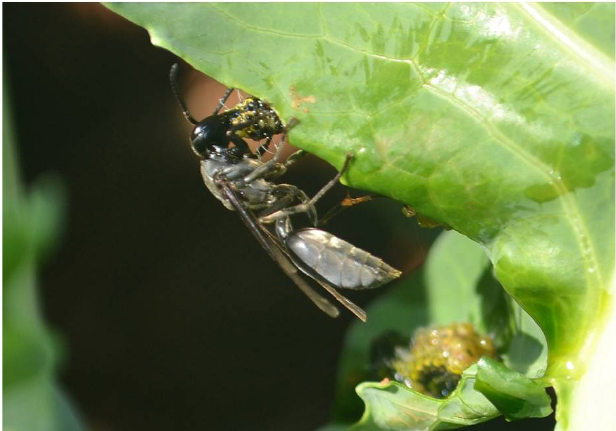
Fig 2 . Social wasp Polybia ignobilis (Hymenoptera: Vespidae) preying on Ascia monuste orseis (Lepidoptera: Pieridae) on a kale plant ( Brassica oleracea var. acephala ).